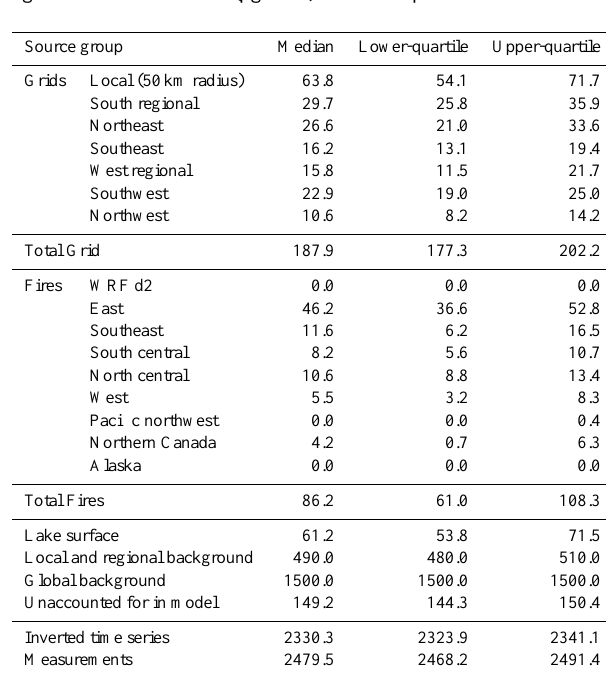
Fig. 13. Map of inventories of all mercury compounds from the Toxic Release Inventory (left), of GEM from the2002NationalEmissionsInventory(middle)andallmercurycompoundsfromthe2002NEI(right). Extent of the back-trajectory grid used for the inversion shown in pink. Areas with zero emissions shown in white.